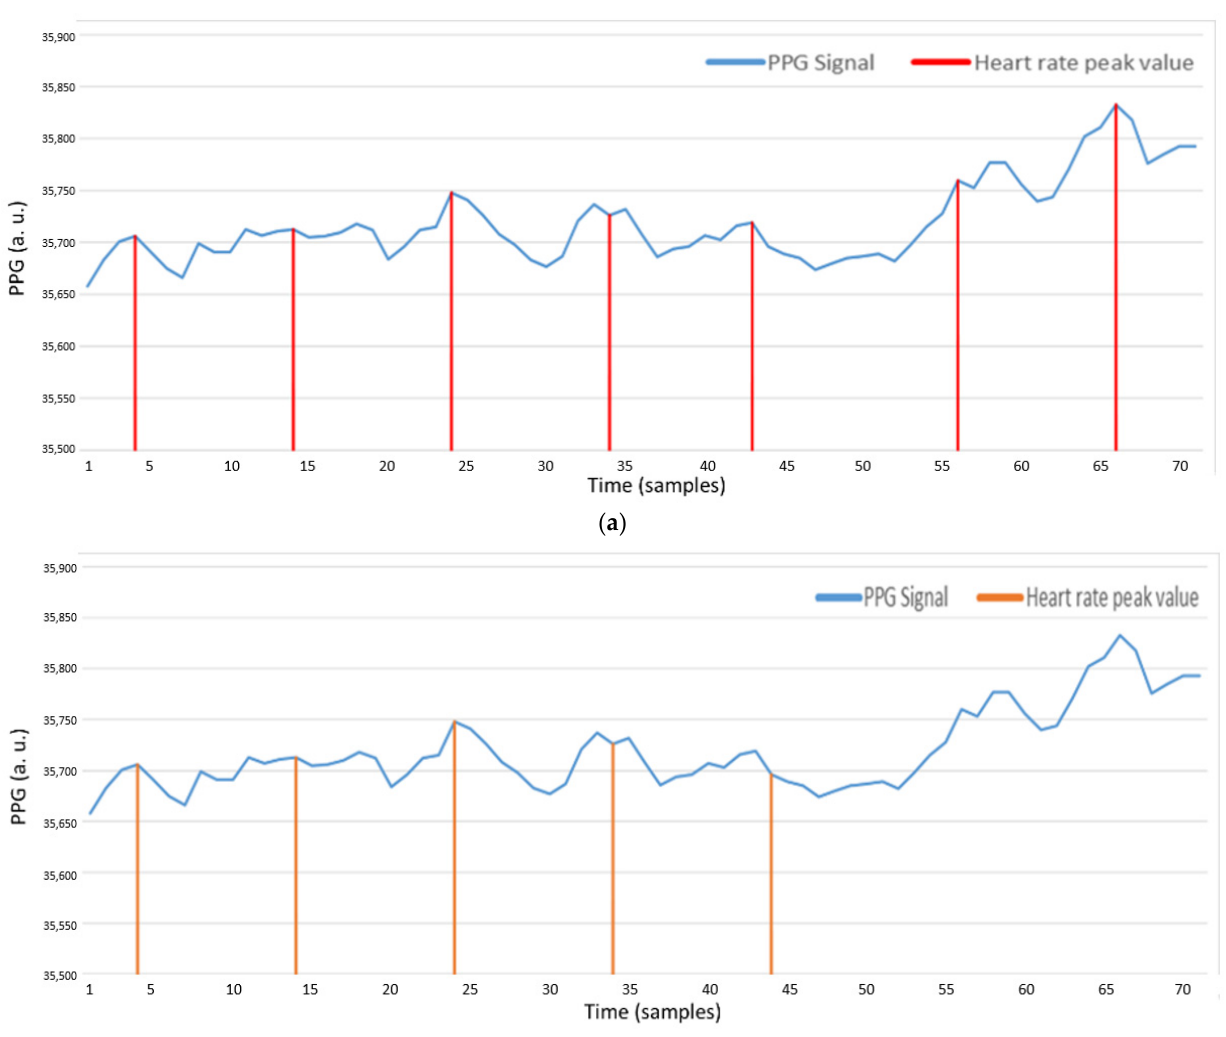
Figure 24. ( a ) PPG signal with AMPD-BL (Threshold = 3/𝐿 , L = 7); ( b ) PPG signal with AMPD-Fuzzy. Figure 24. (a) PPG signal with AMPD-BL (Threshold = 3/ L , L = 7); ( b ) PPG signal with